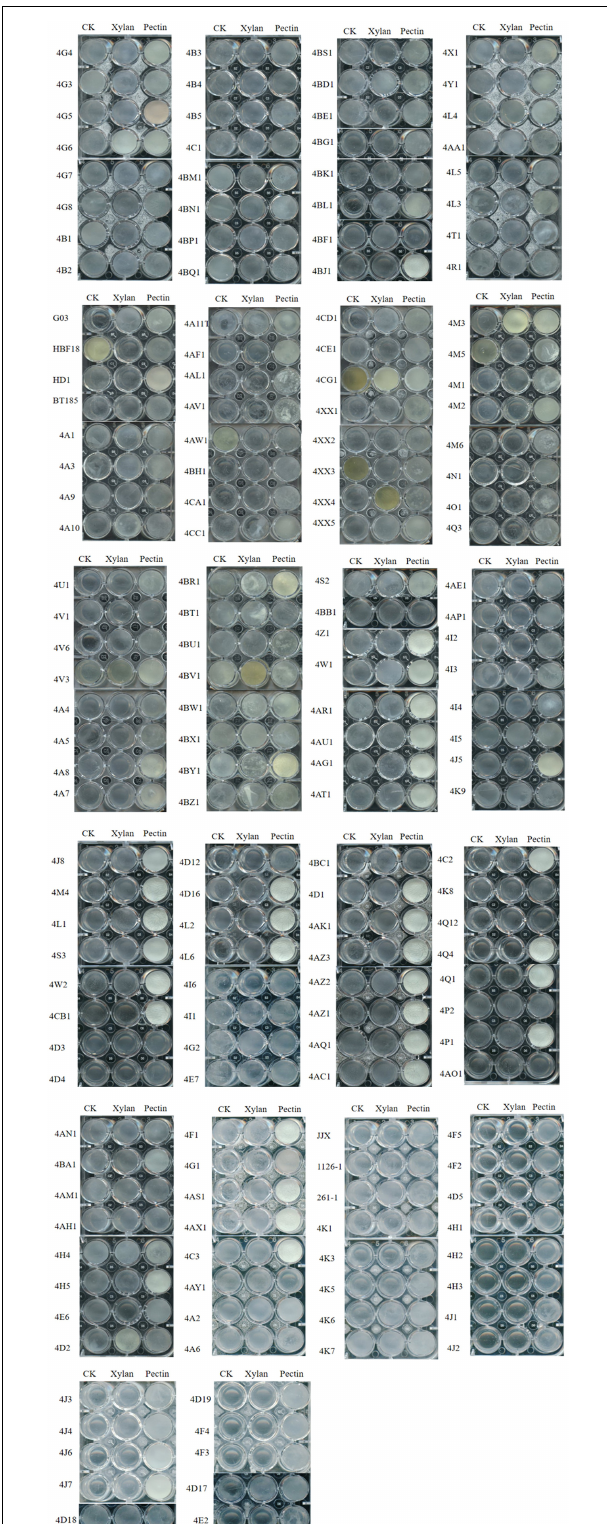
Frontiers in Microbiology |